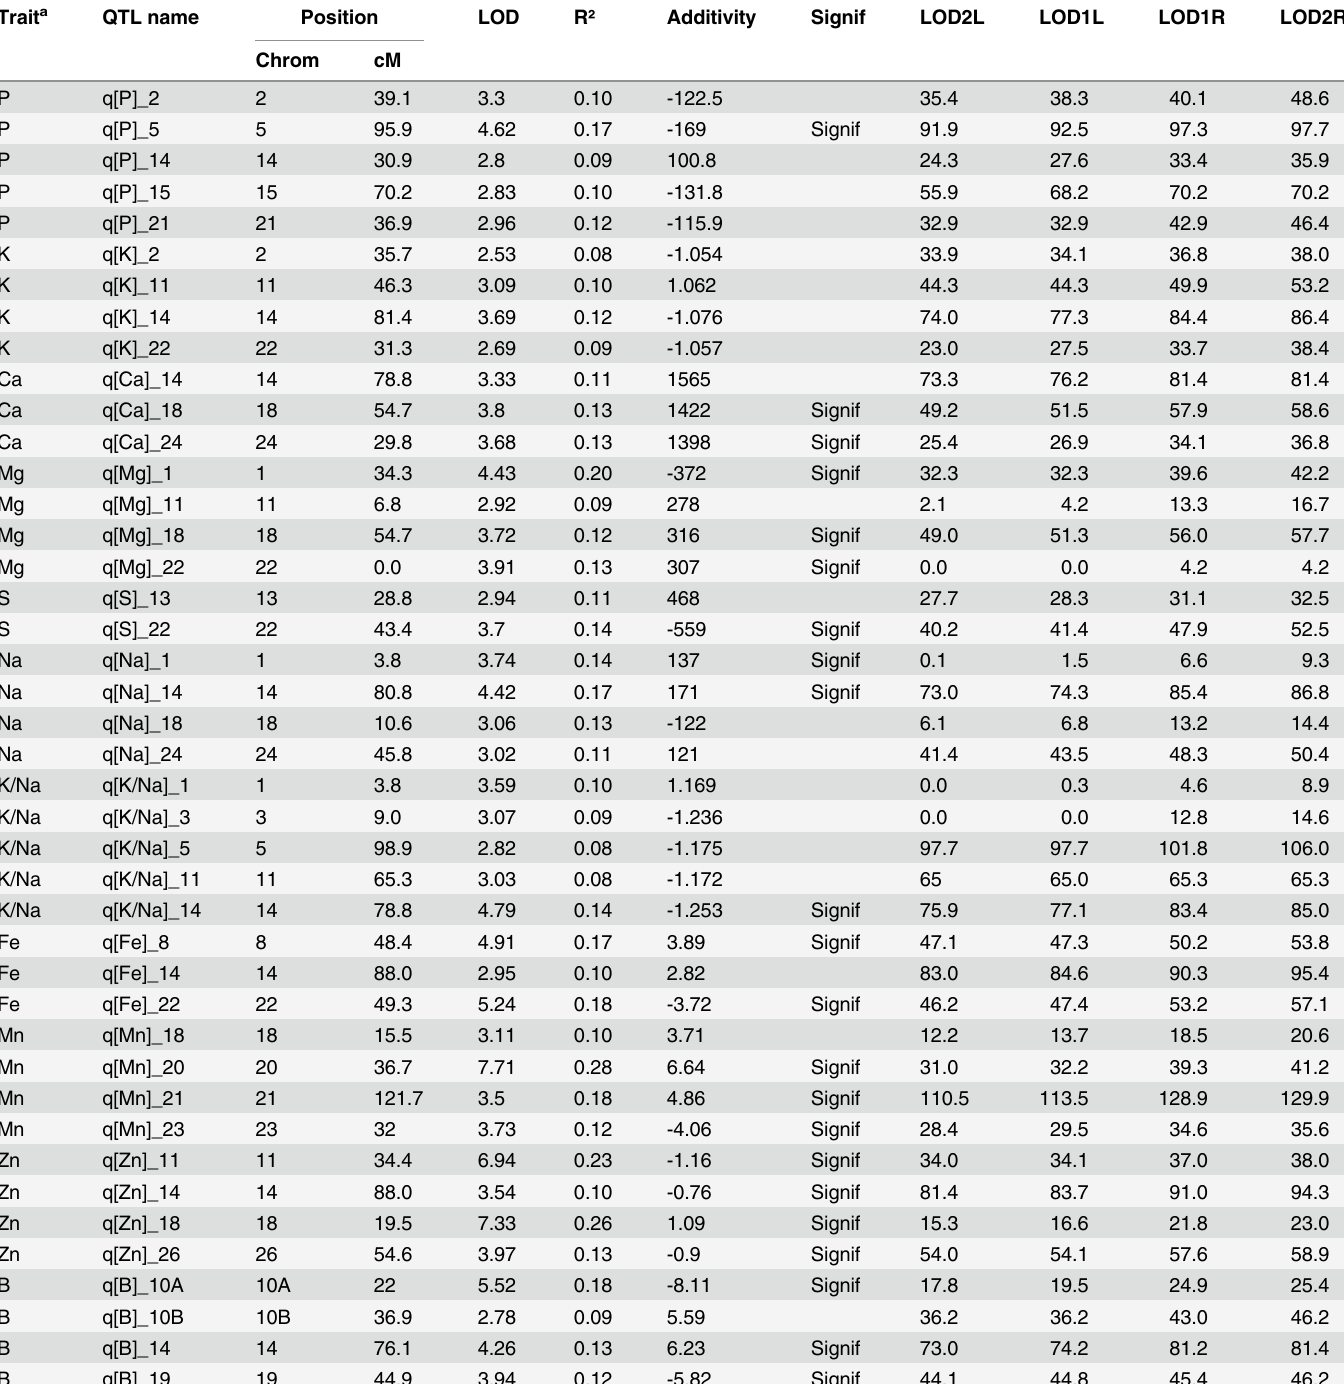
Table 5. Description of QTLs affecting leaf macro-, micro-nutrient and Na concentrations and K/Na ratio in the RIL population of Guazuncho 2 × VH8-4602 as detected by composite interval mapping using QTLCartographer based on the estimates of a two year combined analysis. “ Signif ” column indicates significant QTLs (LOD superior to permutation-based threshold). Putative QTLs with LOD > 2.5 are also indicated. Positive sign of additive effect indicate that parent GUA increases the trait. LOD2L-LOD2R and LOD1L-LOD1R are the positions in cM of the drop-off in 2 or 1 LOD units from the LOD peak, respectively. R² is the proportion of the trait variance explained by the